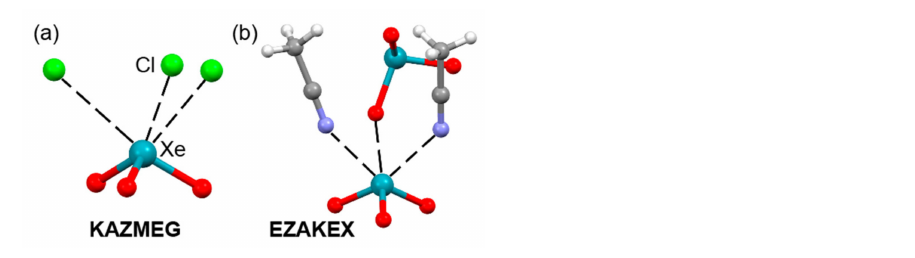
Figure 24. NgBs in the solid state of KAZMEG ( a ) and EZAKEX ( b ) structures. The NgBs are represented using dashed lines.